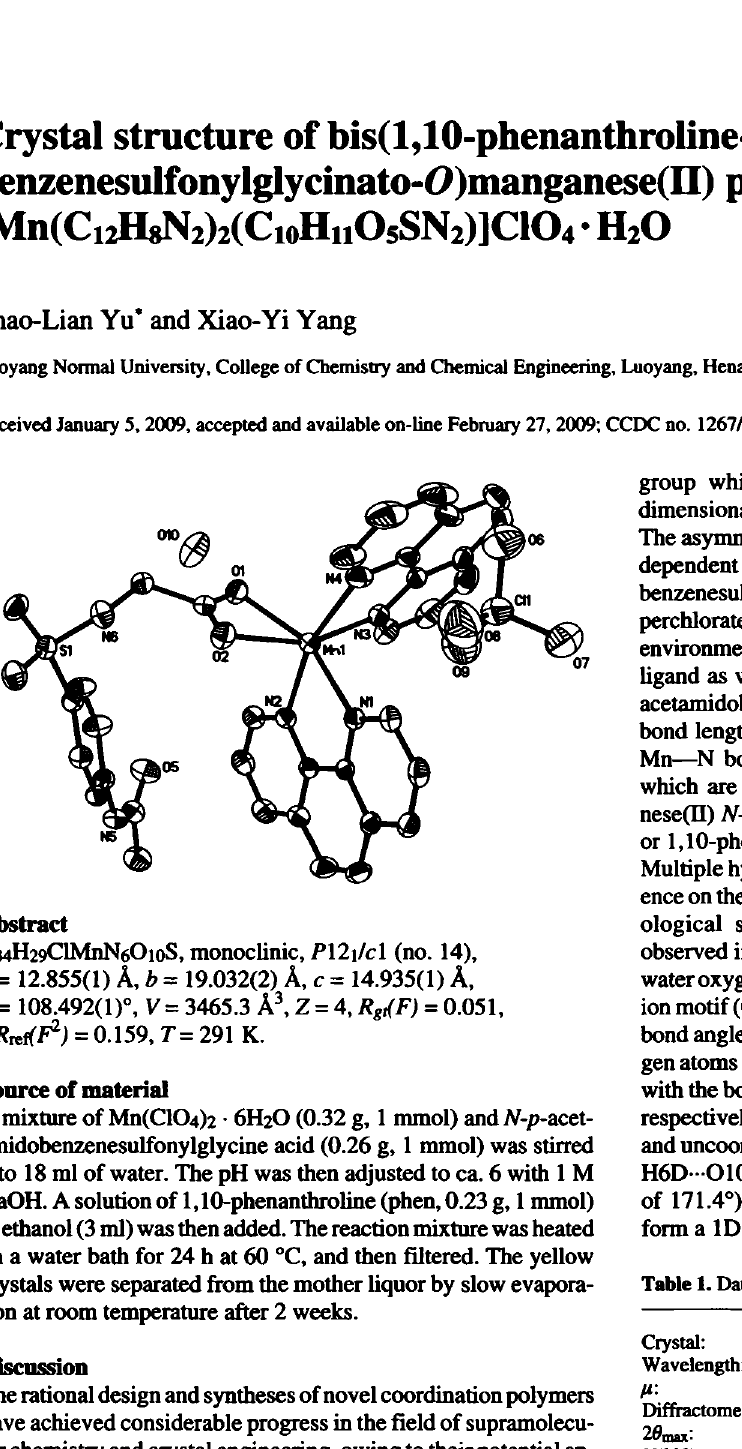
Table 2. Atomic coordinates and displacement parameters (in Â 2